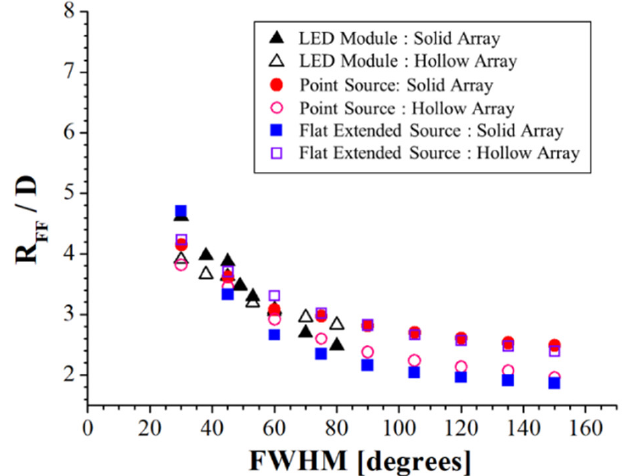
Figure 10. Starting distance of the far field (SDFF)-to-luminaire ratio size versus divergent angle of the light sources.